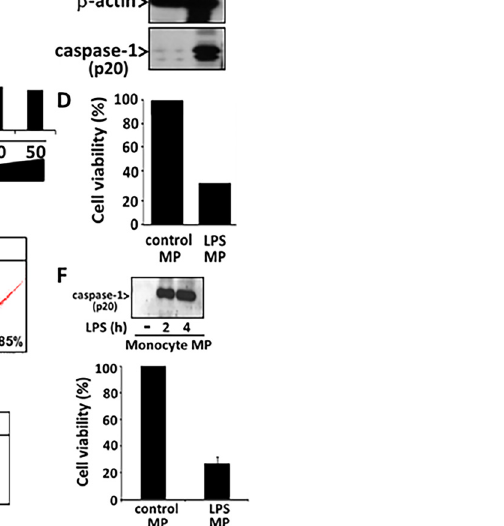
Fig 1. Microparticles released from monocytic cell THP1 induce human pulmonary microvascular endothelial cell (HPMVEC) death. THP1 cells were cultured at 5,10,15,20 and 50 million/ml and stimulated with LPS (1 μ g/ml) for 2h or left untreated. (A) Microparticles (MP) were isolated from each condition and subjected to HPMVEC and analyzed for cell death using MTS assay. (B) MPs were also subjected to careful normalization by total protein prior to subjecting to HPMVEC. (B) Immunoblot analysis of both control MP from 50X10 6 THP1/ml and LPS MP from 10X10 6 THP1/ml, normalized based on total protein content was analyzed for β -actin (loading control) and presence of active caspase-1 (p20). (C) Normalized MP fractions (stained with DilC16) were also analyzed by flow cytometry. (D) These MP fractions were then subjected to HMPVEC and analyzed for cell death by MTS assay. (E) LPS amounts were measured from MPs isolated from unstimulated THP1 (50X10 6 THP1/ml) and LPS stimulated THP1 (10X10 6 THP1/ml) and nonMP fractions using LAL assay. (F) MPs were also isolated from primary monocytes from Red Cross buffy coats. Monocytes were isolated from buffy coats and stimulated with LPS similar to THP1 cells for 2 and 4 h. Isolated MPs were analyzed for presence of active caspase-1 (p20) and induction of HPMVEC cell death (MPs form 2h stimulation used for MTS assay). Quantitative analysis for n = 2